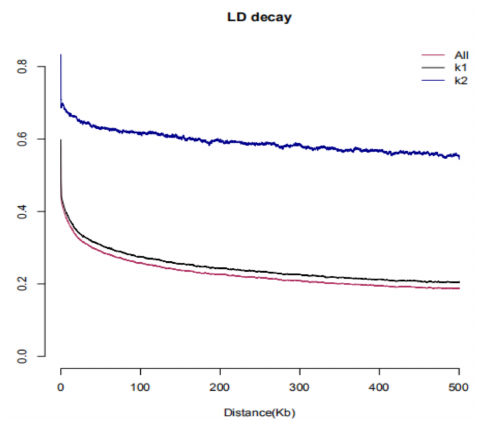
Figure 5. Analysis of